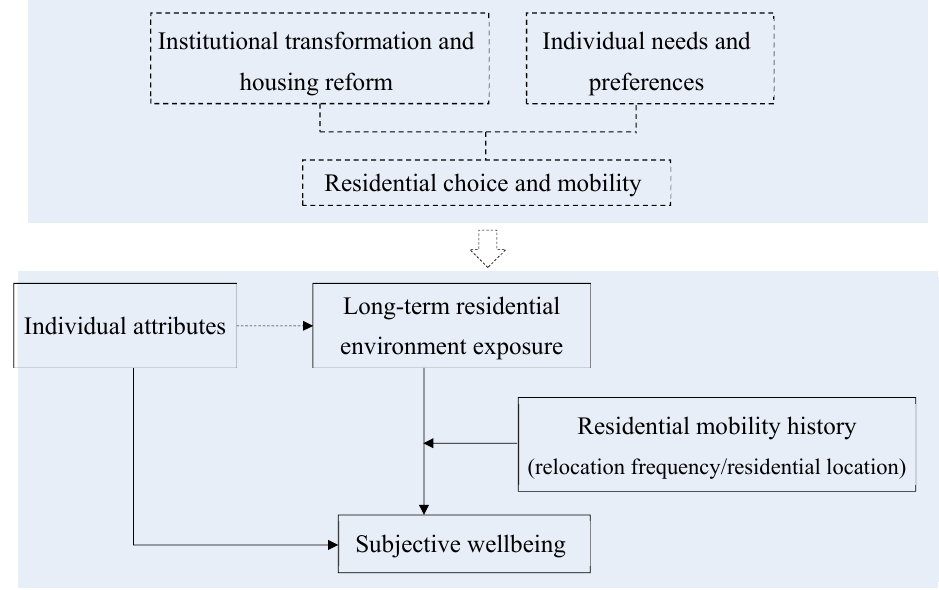
Figure 1. Conceptual framework.